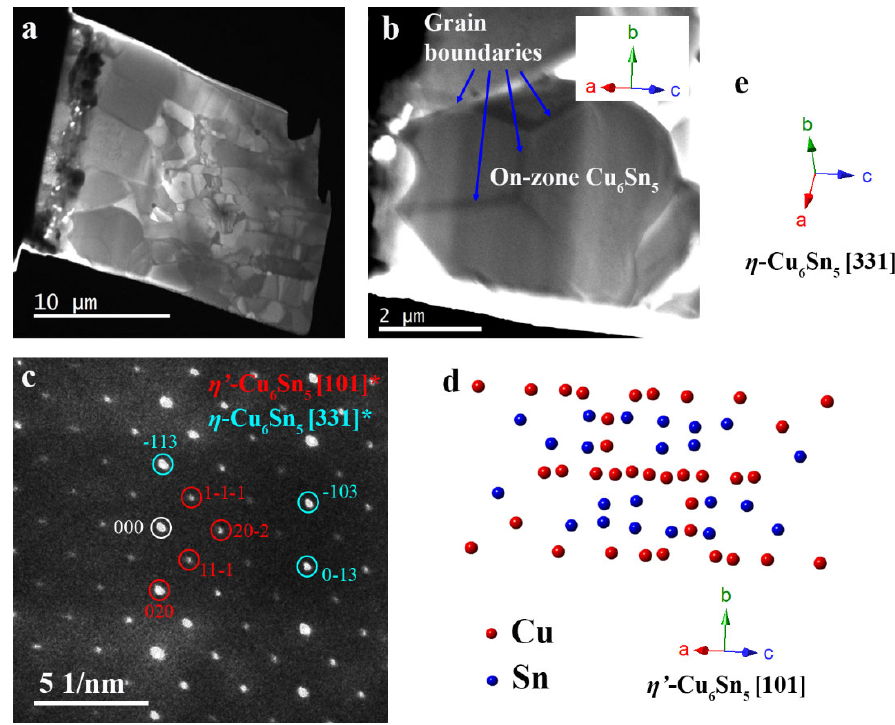
Figure 5. ( a ) Low magnification image of the lamellar after the heating experiment, ( b ) image of the on ‐ zone Cu 6 Sn 5 grain after tilting, ( c ) the SAED pattern and ( d ) a schematic of the crystal structure of the on ‐ zone η ’ ‐ Cu 6 Sn 5 grain showing the grain orientation, and ( e ) the equivalent orientation in a η ‐ Cu 6 Sn 5 crystal to produce the diffraction pattern indexed in ( c ).